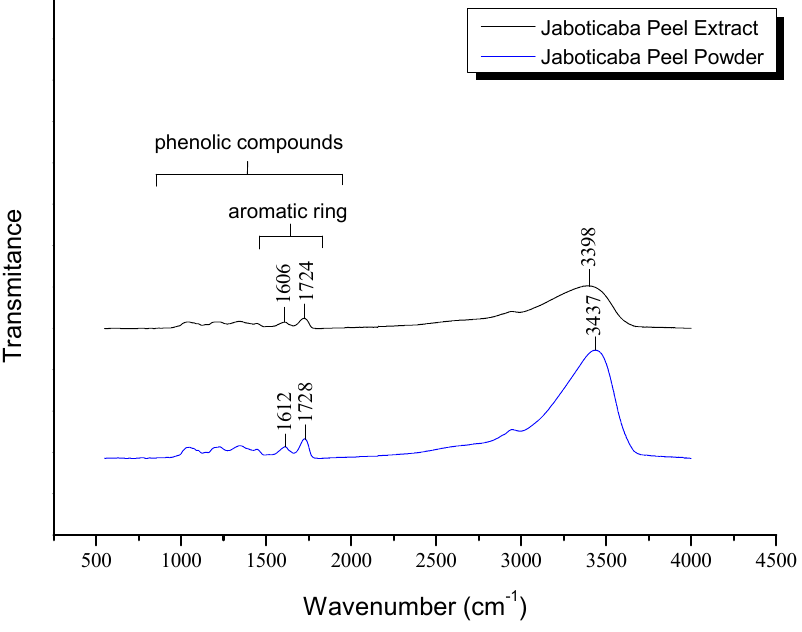
Figure 3. FTIR spectra of the jaboticaba peel powder and extract.